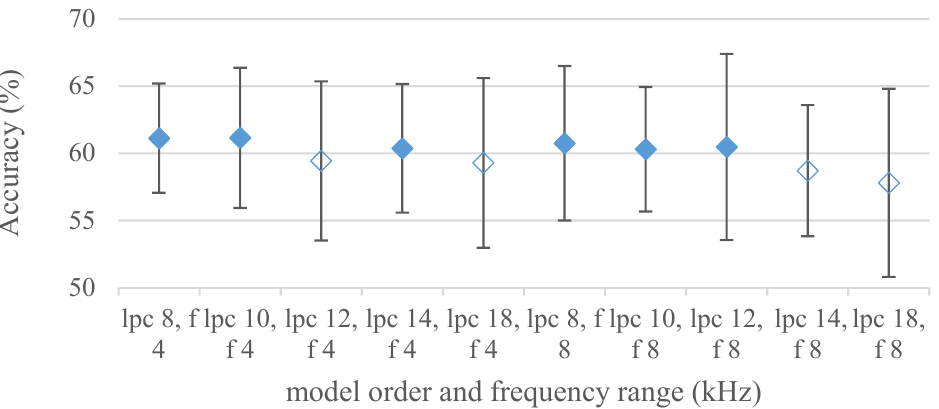
Figure 16. Averaged accuracies and standard deviations for spectrograms constructed over excitation signals with different LPC model orders (lpc) {16, 18, 20}, maximal frequencies (f) {4, 8 kHz}, and no pre-emphasis. Filled marks show equally performing settings.